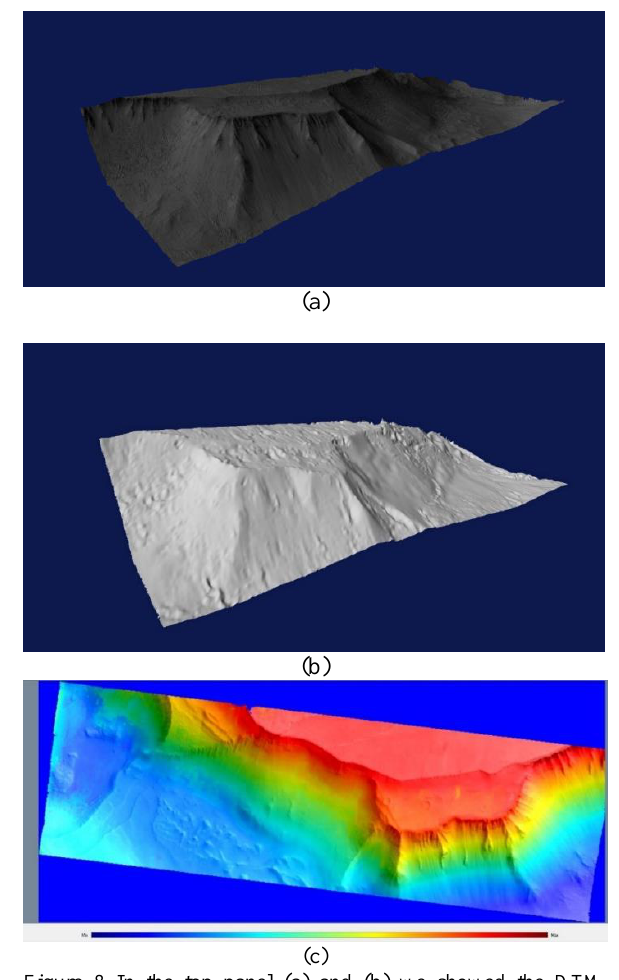
Figure 8 In the top panel (a) and (b) we showed the DTM reconstruction respectively texturized and as simple mesh. In (c) the color-mapped reconstruction snapshot of the MUI. Colormap is limited by 6-8.1